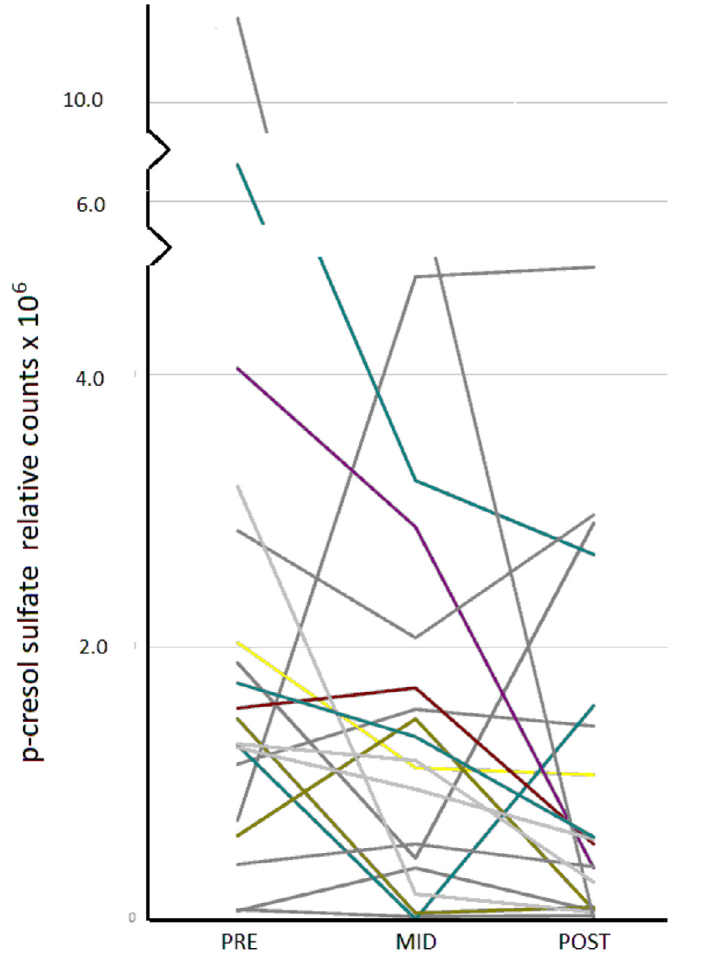
Figure 1. Serum levels of p-cresol sulfate immediately before (PRE), during (MID), and within 24h of completion (POST) of a course of broad-spectrum